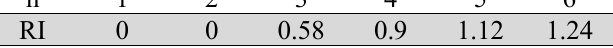
Randomly Generated Consistency Index (RI)